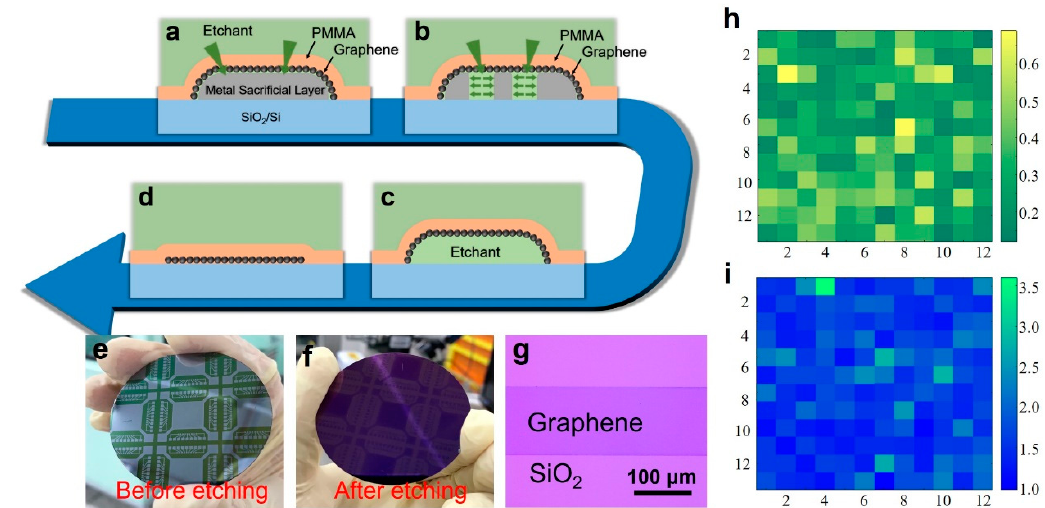
Figure 5. ( a – d ) Schematic illustration of the etching process of our in-situ, transfer-free growth method. ( a ) After the graphene growth, PMMA coating is spun on the sample surface. ( b ) When the sample is immersed in the metal etchant, the etchant can efficiently penetrate through the molecular gap of PMMA and the grain boundary of the graphene to achieve the metal etching. ( c , d ) After the metal is completely etched away, the PMMA/graphene films will fall on the substrate. ( e , f ) Wafer-level graphene growth. The photograph of the sample before ( e ) and after ( f ) the metal sacrificial layer etching. ( g ) An optical image of the graphene at 1000× magnification. ( h , i ) Raman mapping of the D/G and G/2D ratios of the graphene over 50 × 50 µm.